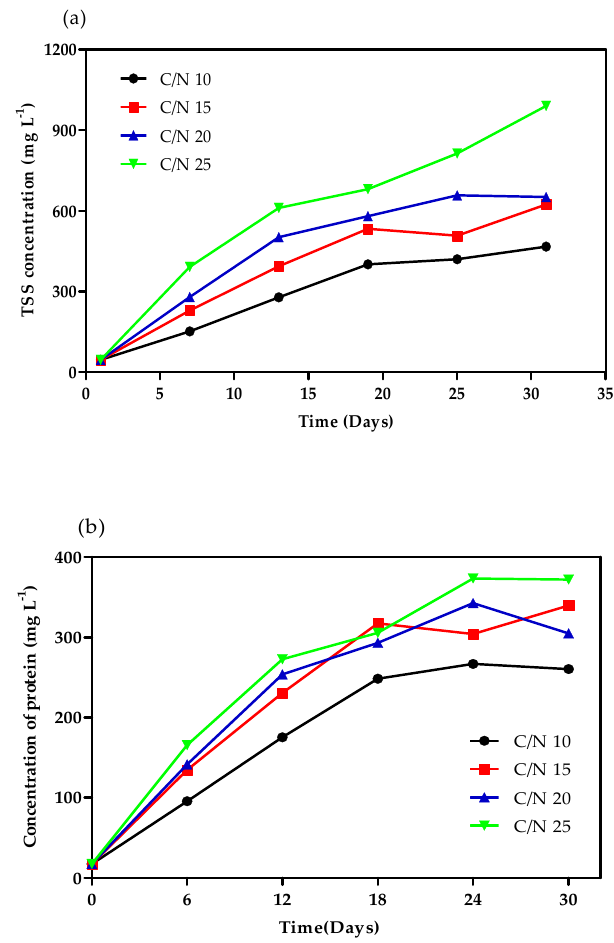
Figure 3. The TSS concentration ( a ) and concentration of protein ( b ) in different C/N ratios.